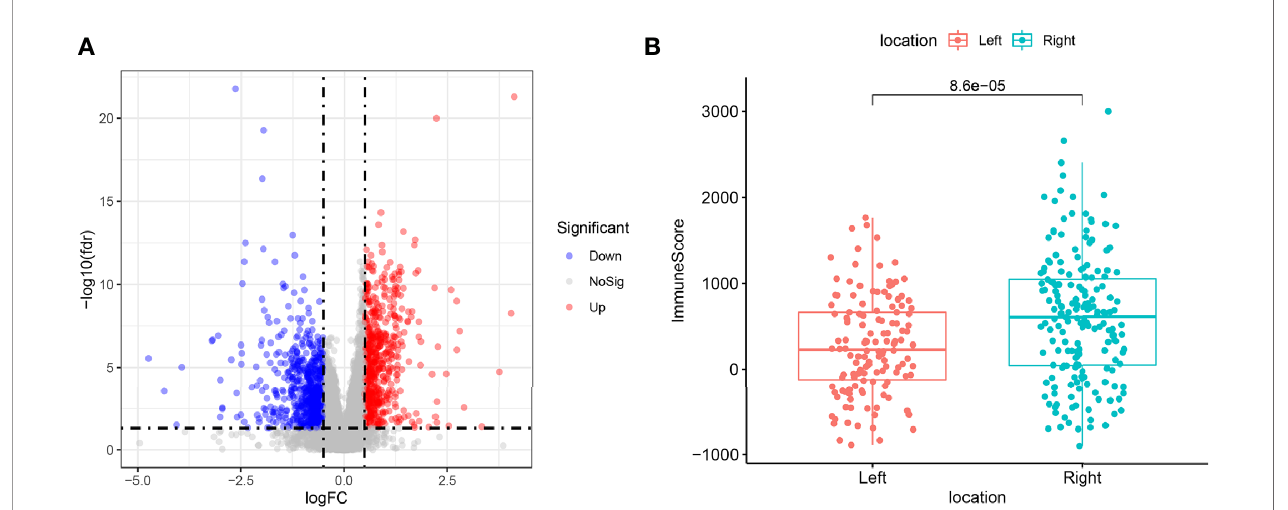
FIGURE 1 | (A) Differentially expressed genes between left-sided colon cancers (LCCs) and right-sided colon cancers (RCCs). Red and blue circles indicate high and low genes expression, respectively. (B) Differences in immune score between LCCs and RCCs. LCCs and RCCs, left and right-sided colon adenocarcinoma.